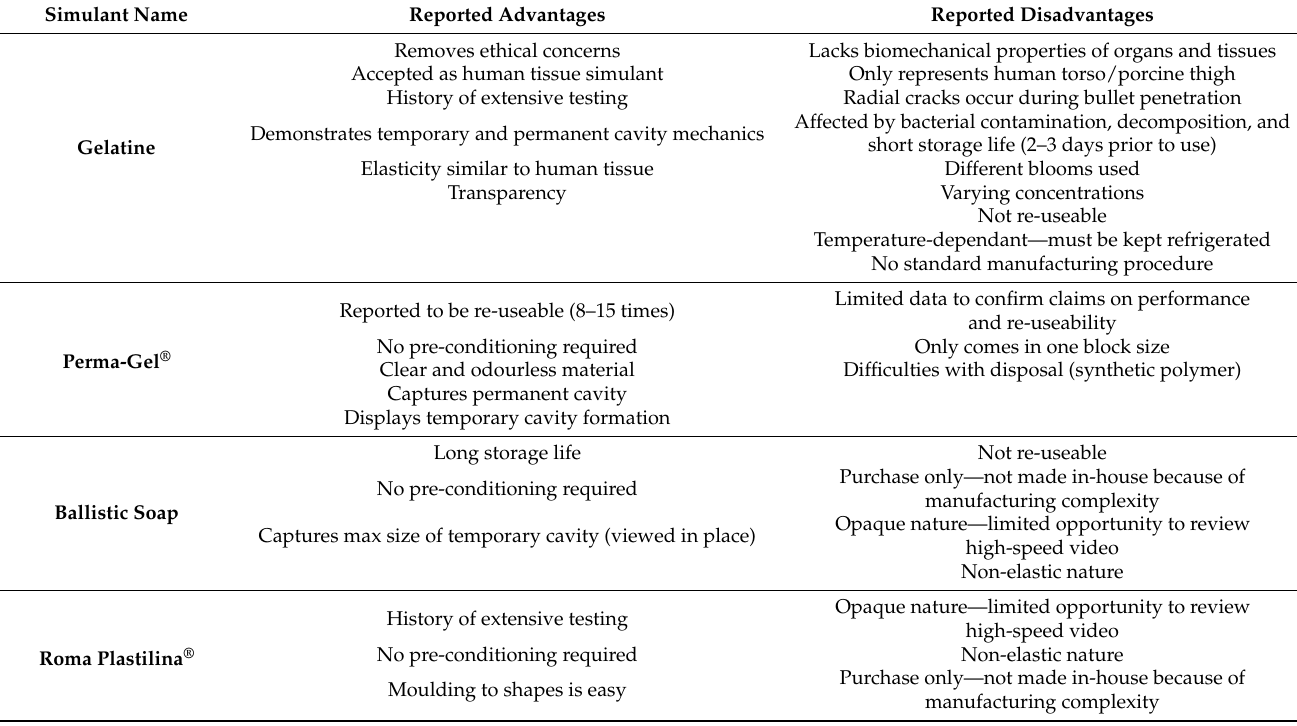
Table 1. Survivability Simulant Summary